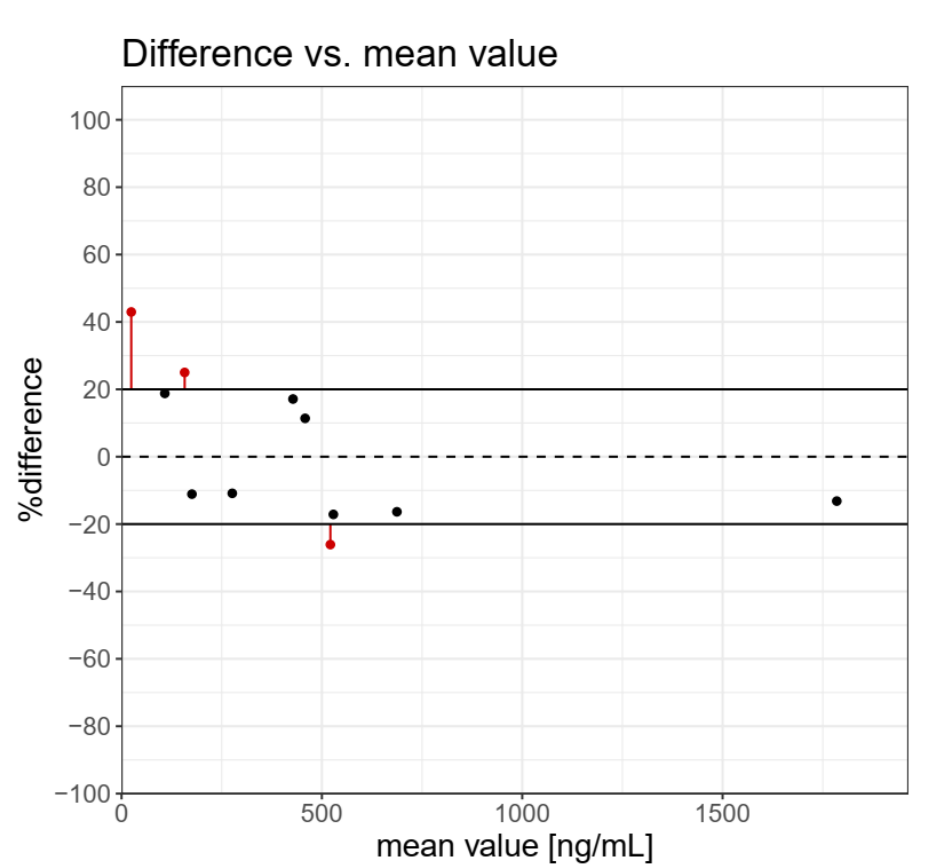
Figure 2. Difference vs. mean value for tributyltin determination in real sediments samples and BCR 464 freshwater sediment. The cumulative %ISR for 11 samples was 72.7% and met acceptance criteria ( ≥ 67%) for comparability of the analytical methods tested.